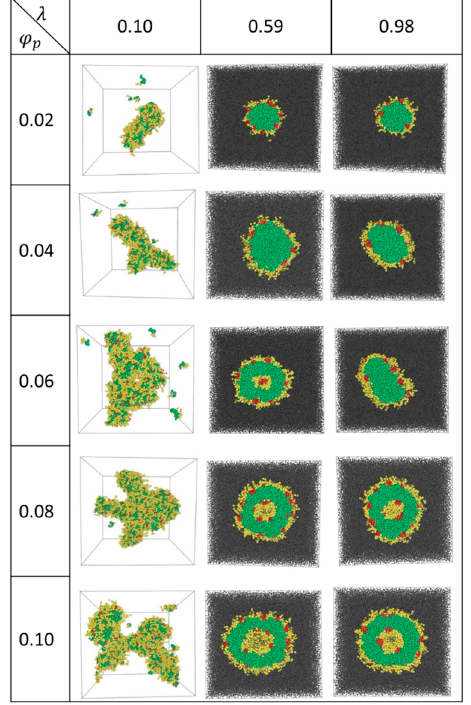
Figure 1. Aggregate structures for λ = 0.10, 0.59 and 0.98 at various φ (cid:2926) . Green, yellow, red, and grey beads refer to A-, B-, C-, and S-beads, respectively. For λ = 0.10, S-beads (grey) are omitted for clarity. At λ = 0.98, spherical raspberry micelles with A-bead cores (green) are formed at low φ (cid:2926) . These micelles have shells that are made mainly of B-beads (yellow) with small C-bead domains (red) that give these micelles the appearance of raspberries. Some B-bead segments on the shell are hydrated by S-beads. The hydrated B-beads extend out of the skin into the solvent space (grey) as yellow ‘hair’ growing out of the aggregates. The shapes of these raspberry micelles change from spherical ( φ (cid:2926) =